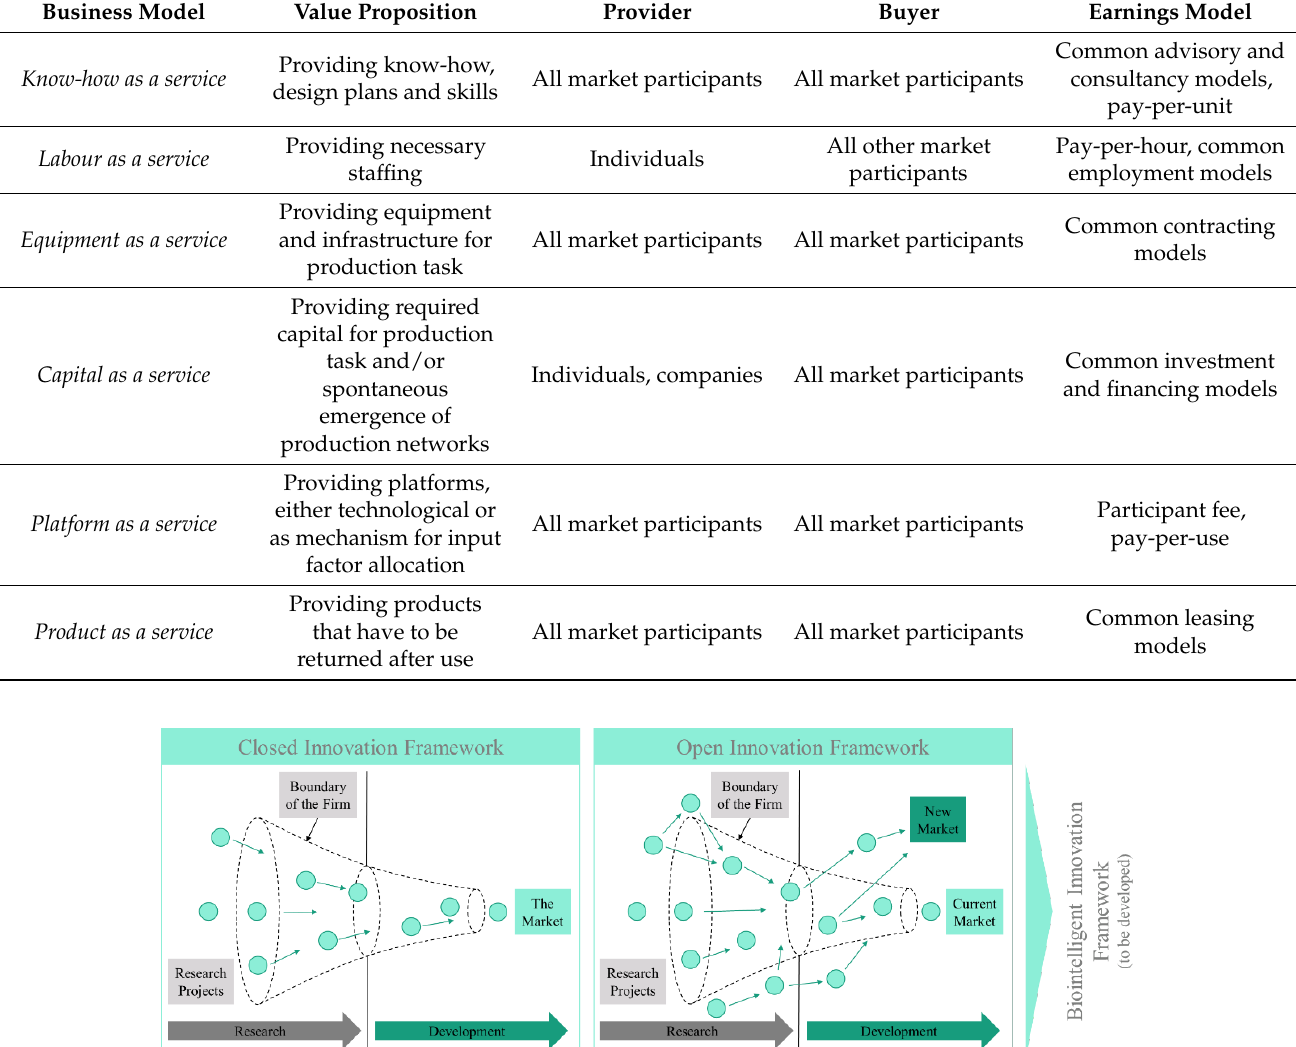
Table 2. Design approaches for potential BMs in biointelligent value creation system.